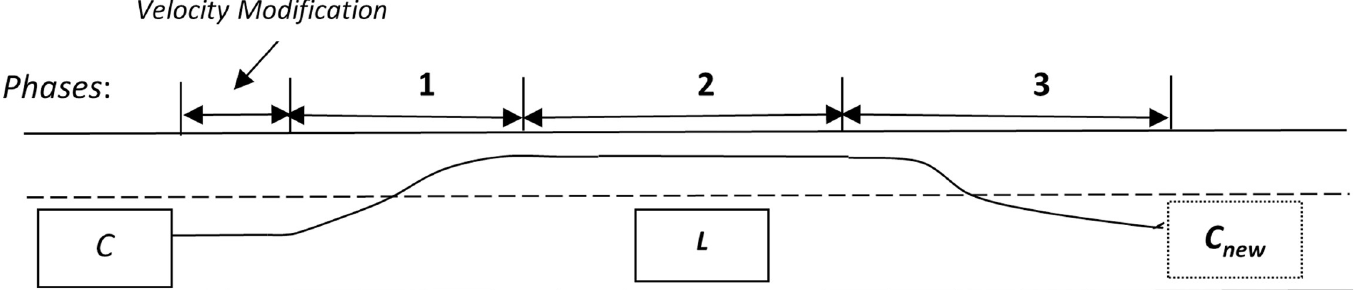
Fig 1. Stages of overtaking in complex